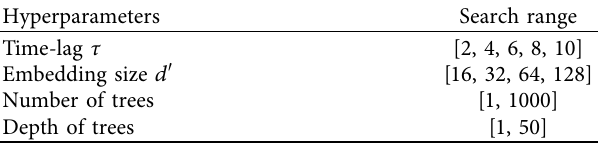
Table 3: Value specified for key